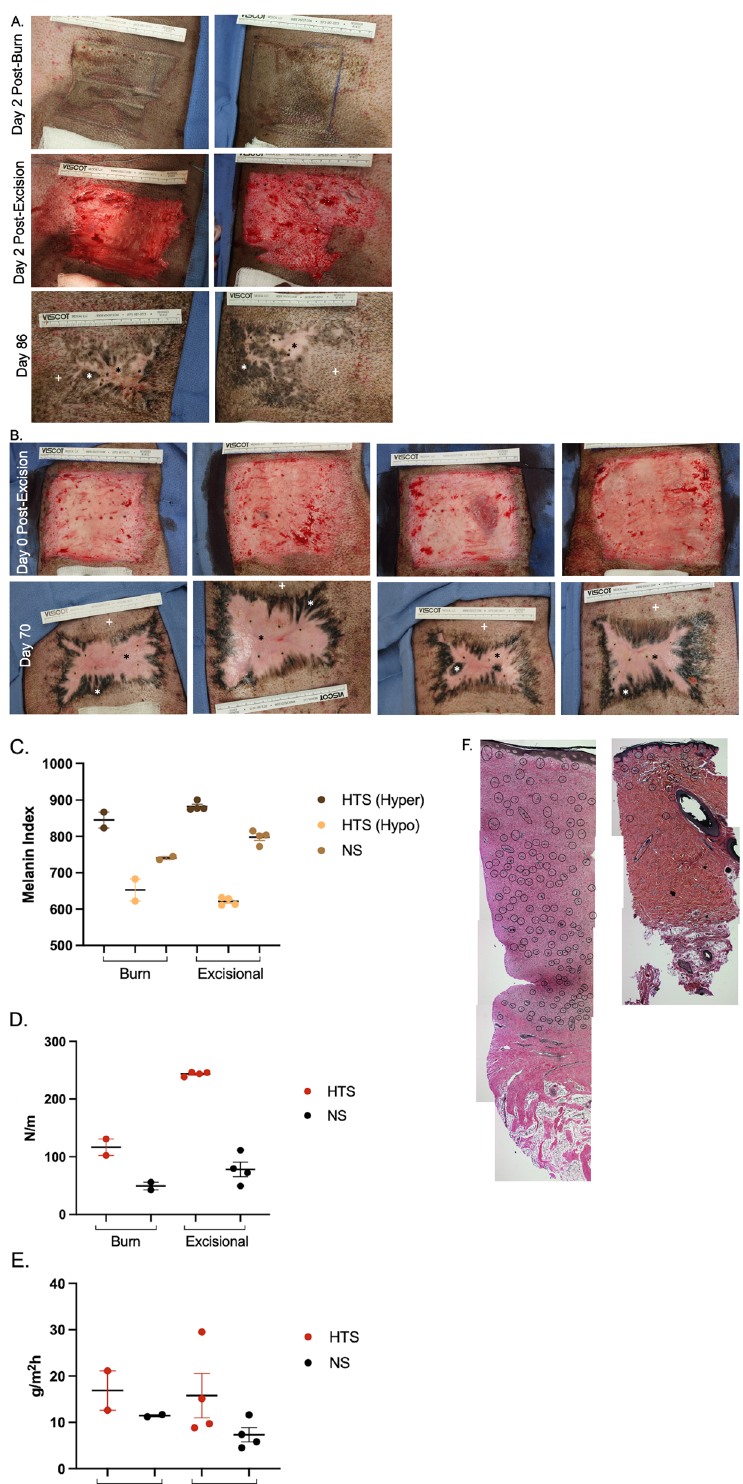
Figure 1. Full thickness burn and injury and excision or excisional injury alone in red Duroc pigs yield HTS with many of the characteristic features of human HTS. Animal 1 burn injury, excision, and final burn HTS (n = 2 different areas) result at Day 86 ( A ). Animal 2 excisional injury and final excisional HTS (n = 4 different areas) result at Day 70 ( B ). Non-invasive measurements of melanin ( C ), elasticity ( D ), and TEWL ( E ). Verhoeff- Van Geison staining of HTS (left) and NS (right) biopsies. Blood vessels (black circles) ( F ). p < 0.05*, p < 0.01**, p < 0.001***, p <